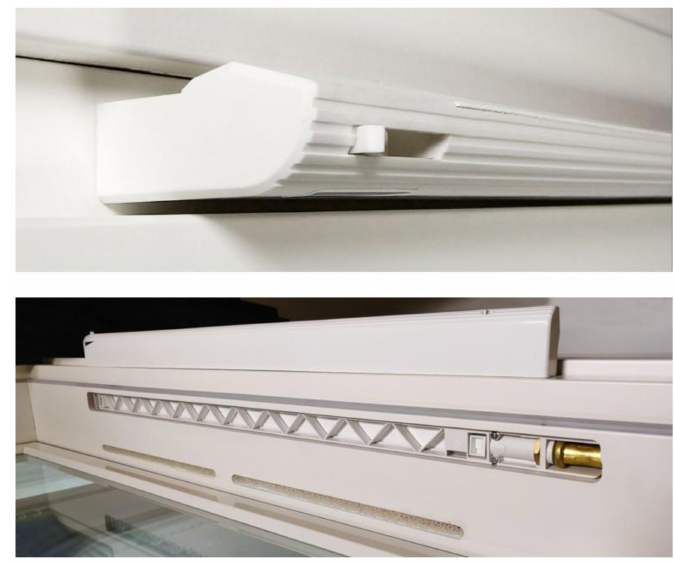
Figure 5. The trickle vent, Biobe ThermoMax A, used in the supply air windows of this study.